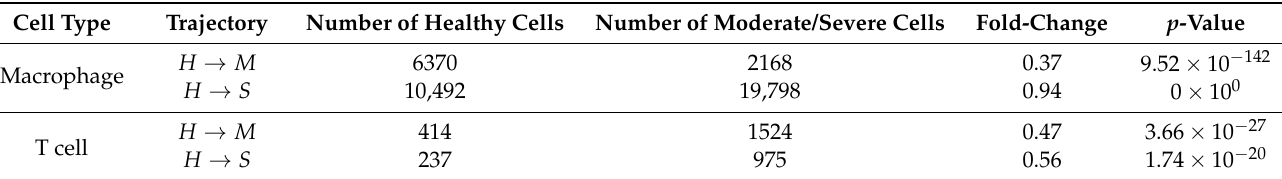
Table 1. The summary of top inferred cellular trajectories of macrophages and T cells. Cell Type Trajectory Number of Healthy